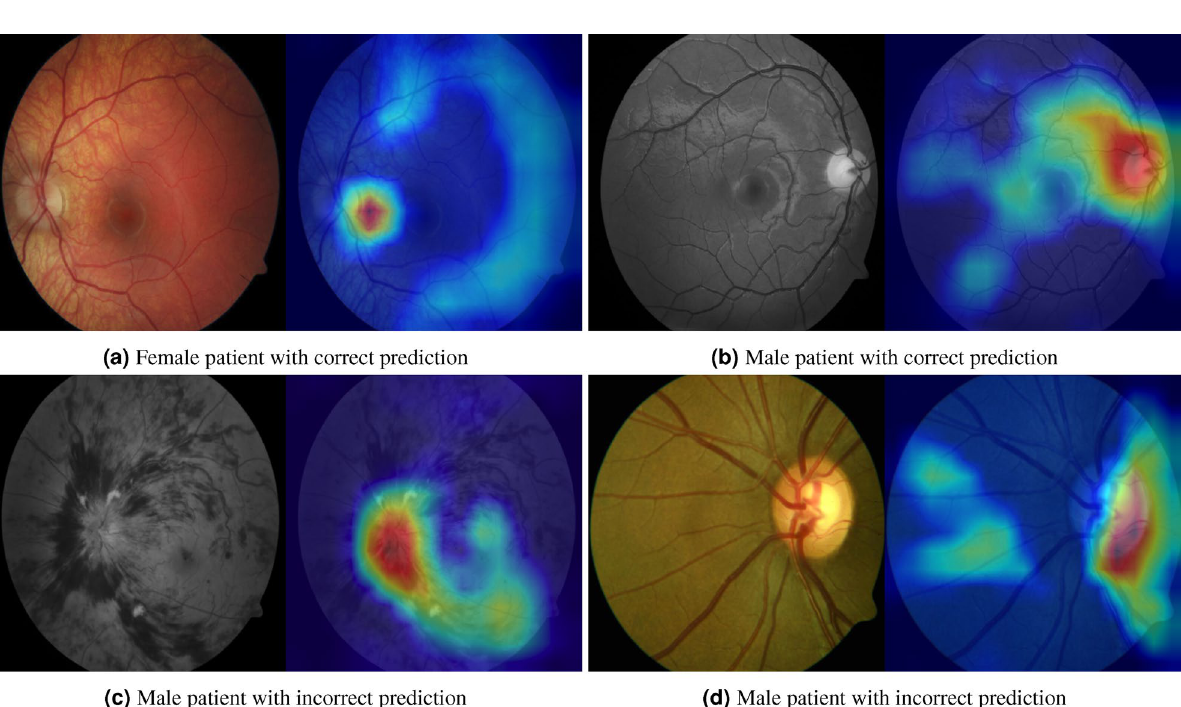
Figure 9. Attention maps of fundus images, top row: correct predictions, bottom row: incorrect